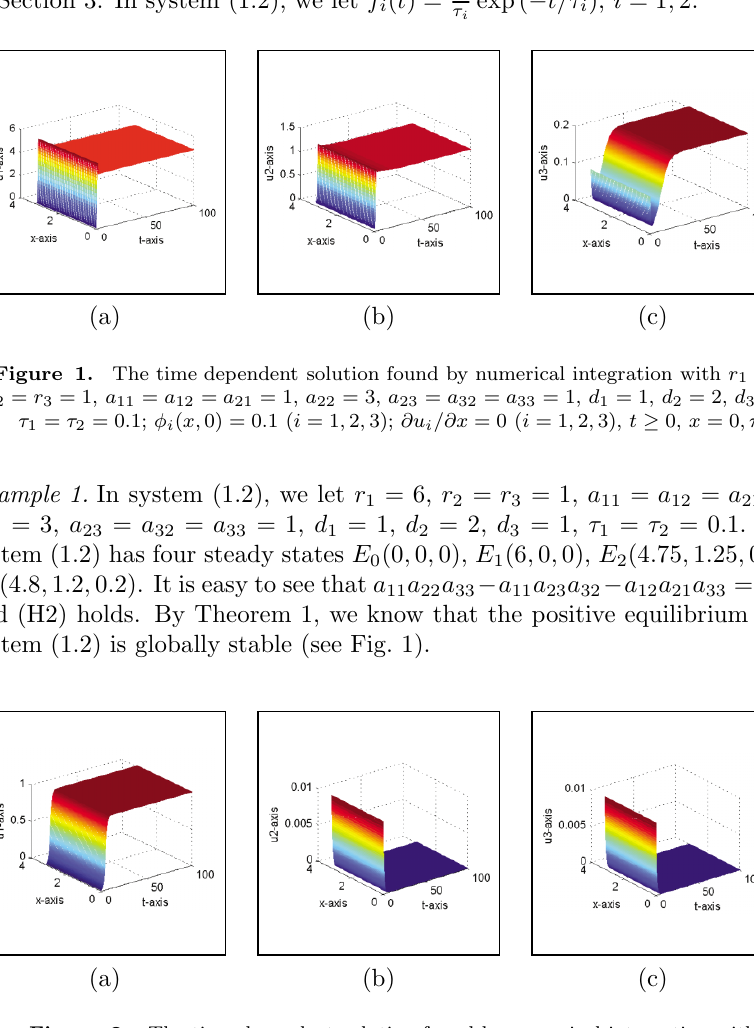
Figure 2. The time dependent solution found by numerical integration with r 1 = r 2 = r 3 = 1, a 11 = a 12 = a 21 = 1, a 22 = 3, a 23 = a 32 = a 33 = 1, d 1 = 1, d 2 = 2, d 3 = 1, τ 1 = τ 2 = 0 . 1; φ i ( x, 0) = 0 . 01 ( i = 1 , 2 , 3); ∂u i /∂x = 0 ( i = 1 , 2 , 3), t ≥ 0, x = 0 ,π